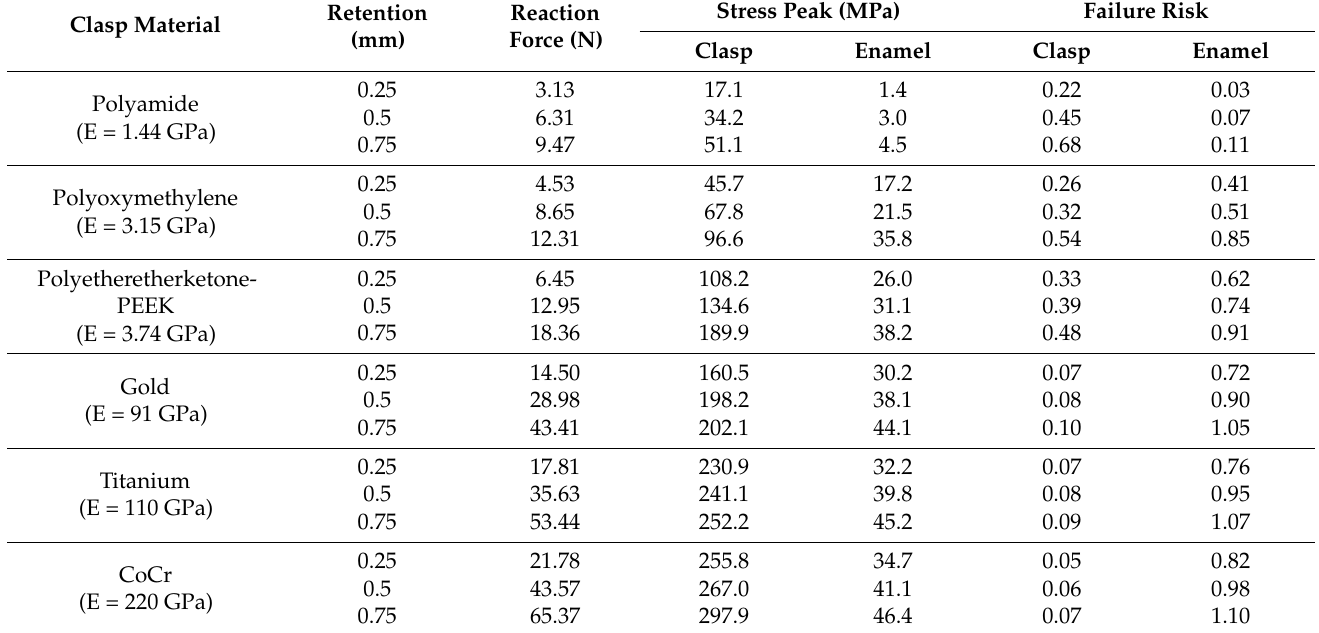
Table 2. Group distribution, reaction force and maximum principal stress peaks and failure risk for the clasp and the enamel according to the clasp material (elastic modulus - E) and undercut. (Reproduced from [109]. with permission from © 2020